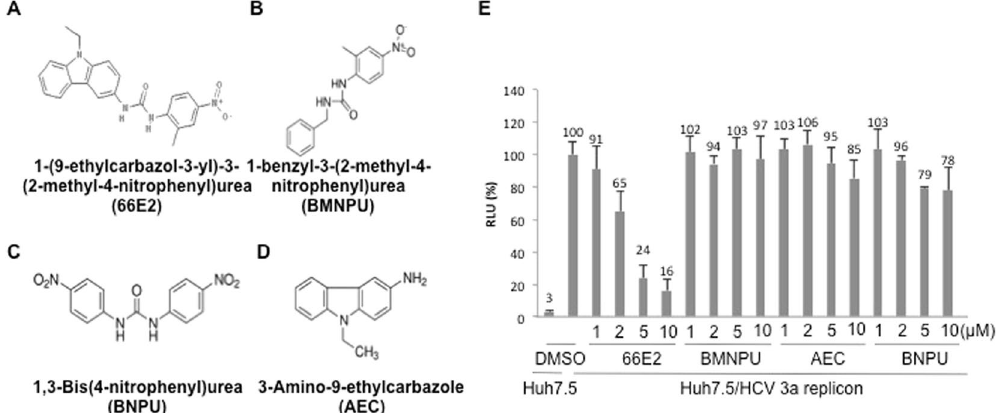
Figure 3. Structure Activity Relationship Analysis. ( A – D ) Structure of 66E2 and its derivatives are depicted. ( E ) G418 resistant HCV-3a replicon expressing Huh7.5 cells were treated with varying concentrations of these compounds. Levels of RNA replication was monitored using the firefly reporter and plotted as % RLU as in Fig. 2A. The assays were performed in triplicates and results presented are representative of three independent assays. The % mean is shown above the bars and the error bars are standard